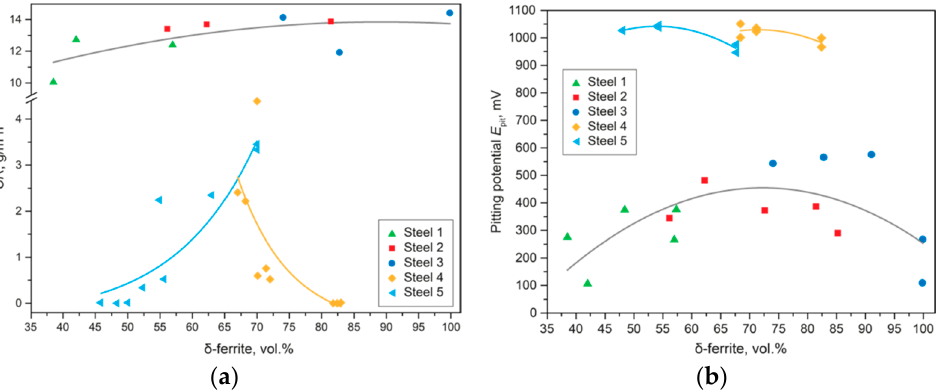
Figure 6. Corrosion properties of the Steels depending on the δ -ferrite content: ( a ) crevice corrosion rate; ( b ) pitting potential (E pit ). rate; ( b ) pitting potential (E pit